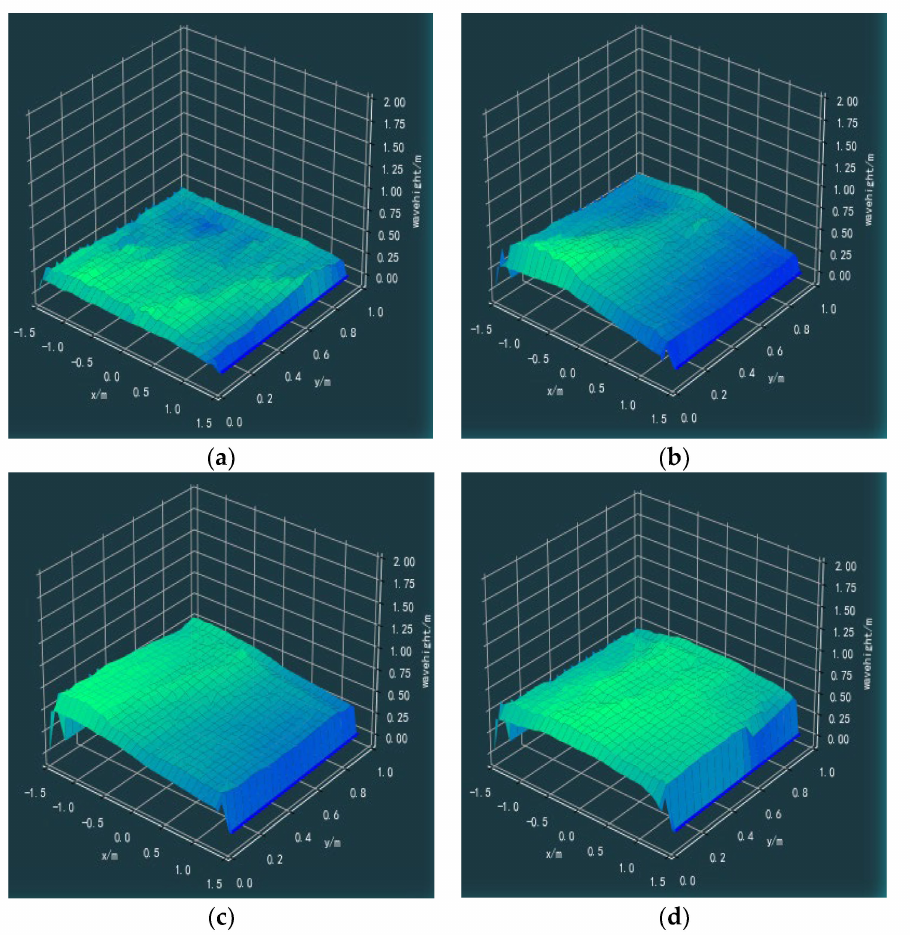
Figure 13. Illustration: ( a ) wave field 3D reconstruction of the first frame image; ( b ) wave field 3D reconstruction of the second frame image; ( c ) wave field 3D reconstruction of the third frame image; ( d ) wave field 3D reconstruction of the fourth frame